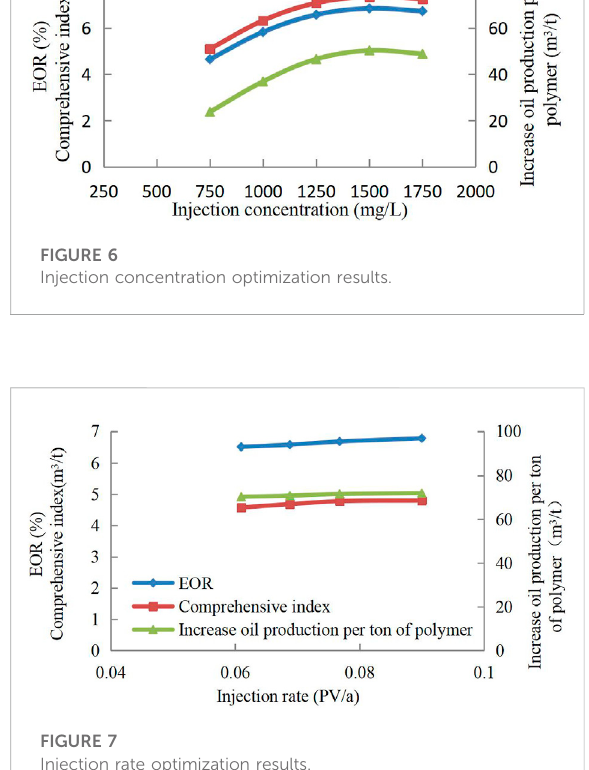
TABLE 7 Values of physical and chemical parameters required for numerical simulation. No. Parameters